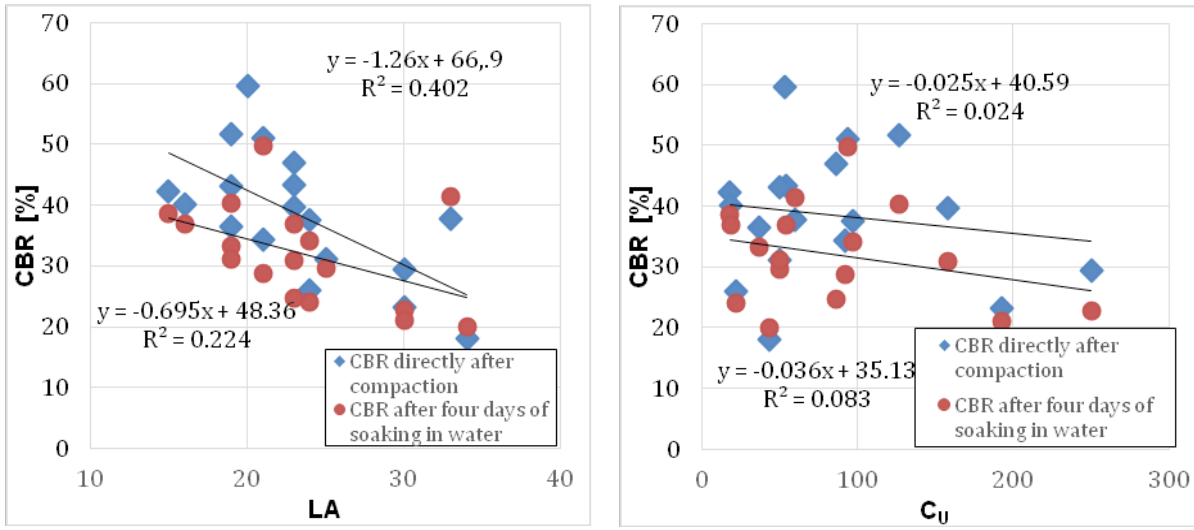
Figure 3: Correlation between CBR and Los Angeles coefficie.